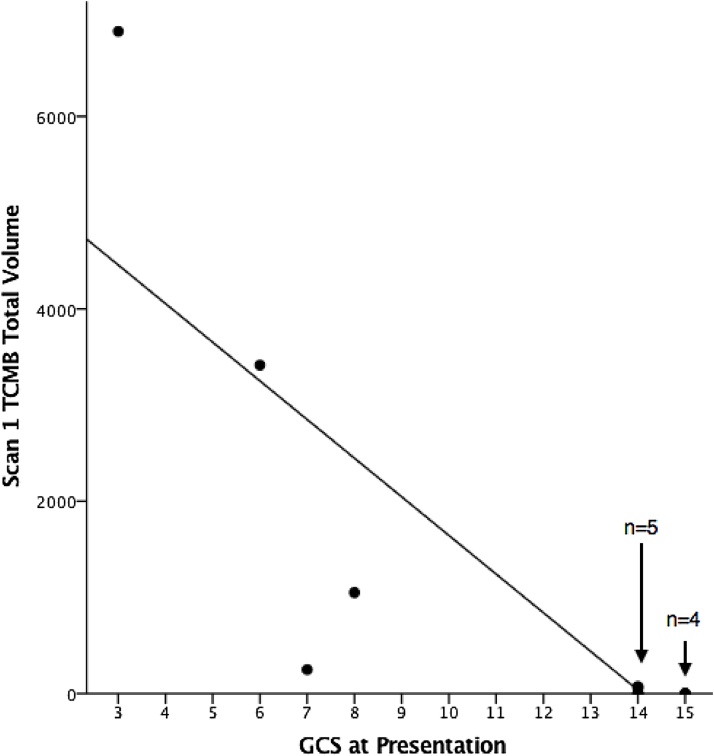
Relationship between initial Glasgow Coma Scale (GCS) and total lesion volume identified on the first scan.Figure 1 Legend. Graphical representation of the relationship between GCS at presentation and total TCMB lesion volume on the first scan. Patients with a poor GCS at presentation ( < 9) all had lesions identified with SWI. Two patients with a GCS of 14 at presentation had lesions identified with SWI. These data points are over-lapping. All other data points for patients presenting with a GCS of 14 or 15 are represented by over-lapping data points. No patients with a GCS of 15 at presentation had lesions identified. A negative correlation was seen between initial GCS and total lesion volume on the first scan (day 0) (R = −0.867, p < 0.001).